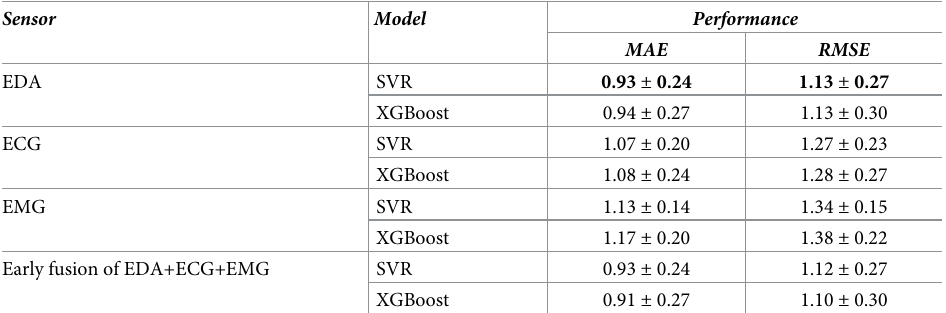
Table 6. The pain estimation performance of subject-dependent model for different sensors and models (Mean ± Standard